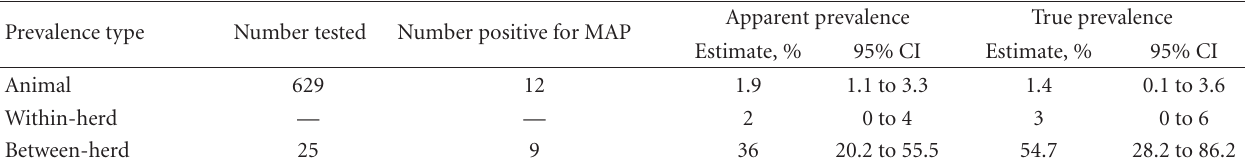
Table 1: Apparent and true prevalence estimates for animal, within-herd, and between-herd prevalences derived from 629 Boer goats in 25 Missouri